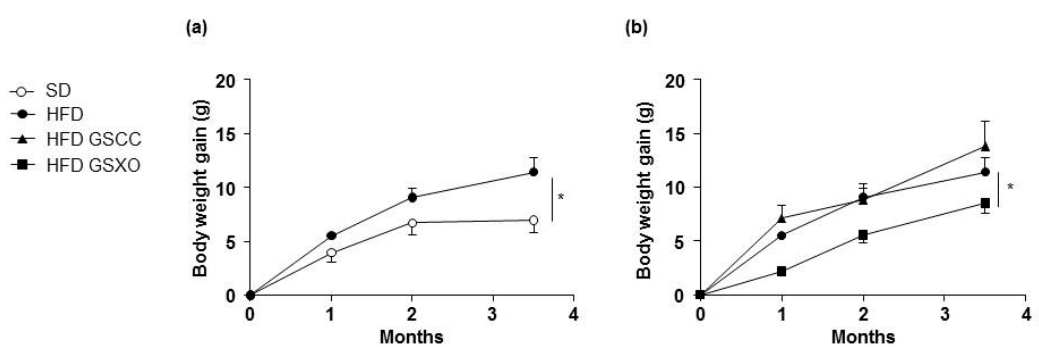
Figure 1. Effect of diet and apple supplementation on body weight of ApoE-/- mice. The evolution of body weight gain ( a , b ) of mice receiving standard diet (SD), high fat diet (HDF) ( a ), or HFD containing GSCC and GSXO ( b ) for 14 weeks. The data were expressed as the mean ± SEM. * p < 0.05.